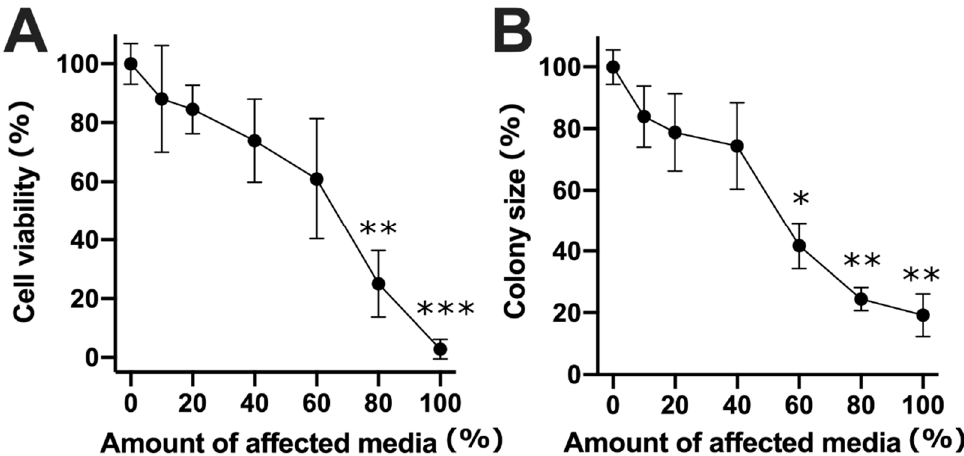
Figure 3. Cell viability ( A ) and cell colony size ( B ) changes after cell growth in a medium containing different ratios of the affected medium. The affected medium was taken from cells that were electroporated (one pulse 1400 V/cm, 100 µs) in the presence of 20 nM bleomycin. The *, **, and *** symbols represent statistical significance of p < 0.05, p < 0.01, and p < 0.001, respectively, compared to the control.